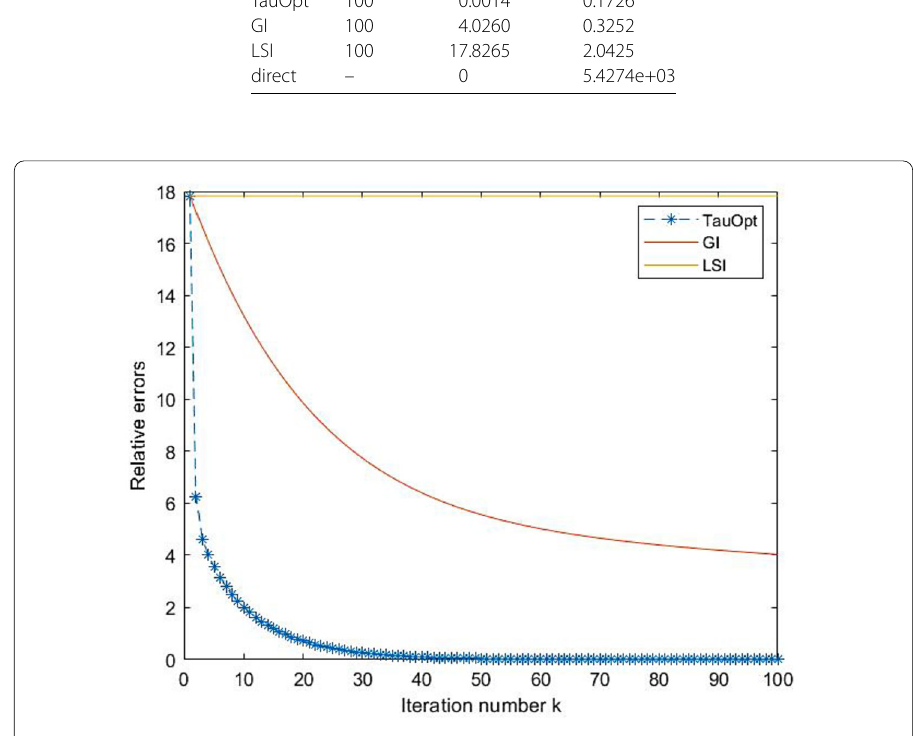
Figure 1 Relative errors for Ex.